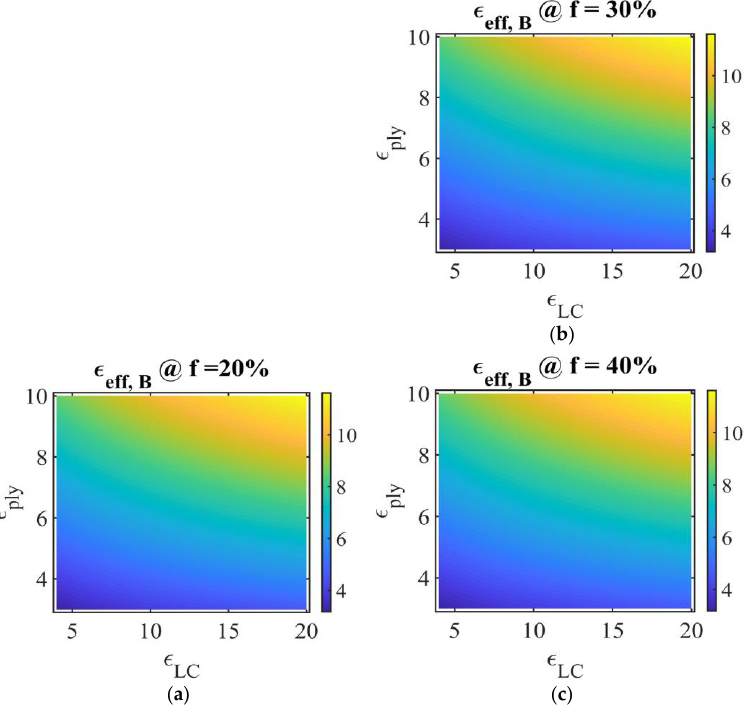
Figure 4. Representation of PDLC film effective permittivity in the Bruggeman model for different LC fractions: ( a ) f LC , a = 0.2, ( b ) f LC , b = 0.3, ( c ) f LC , c = 0.4. Ox: LC permittivity ε LC , Oy: polymer permittivity ε ply ; vertical color bar: PDLC film effective permittivity using the Bruggeman model, symbol @ stands for